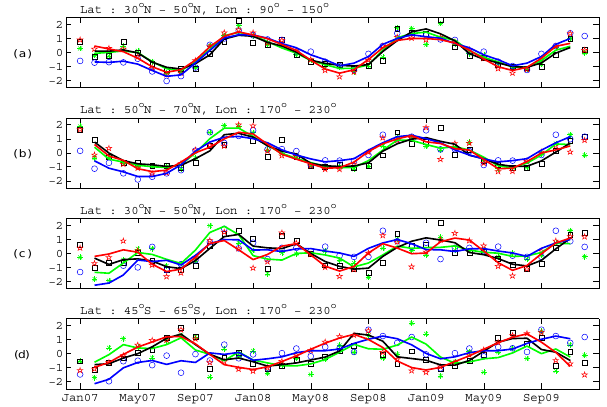
Figure 9. Monthly values of z scores shown by squares, asterisks, stars, and circles for E T p (black), E S p (green), absolute of p (blue), and U (red), respectively, in the selected latitude and longitude ranges as shown on the top left of each panel. Smoothed lines are a 3-month averaging. See text for more detail.